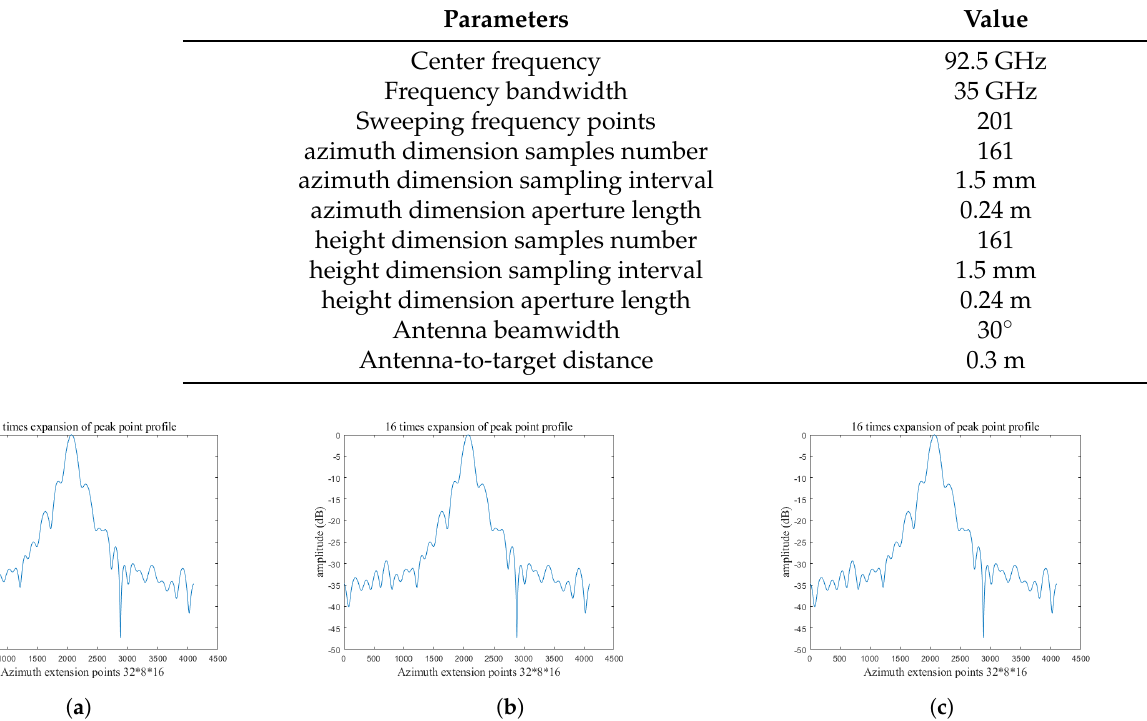
Figure 6. Azimuth amplitude results. ( a ) is the CPU implementation result; ( b ) is the GPU imple- mentation result; ( c ) is the result of the proposed method implementation.